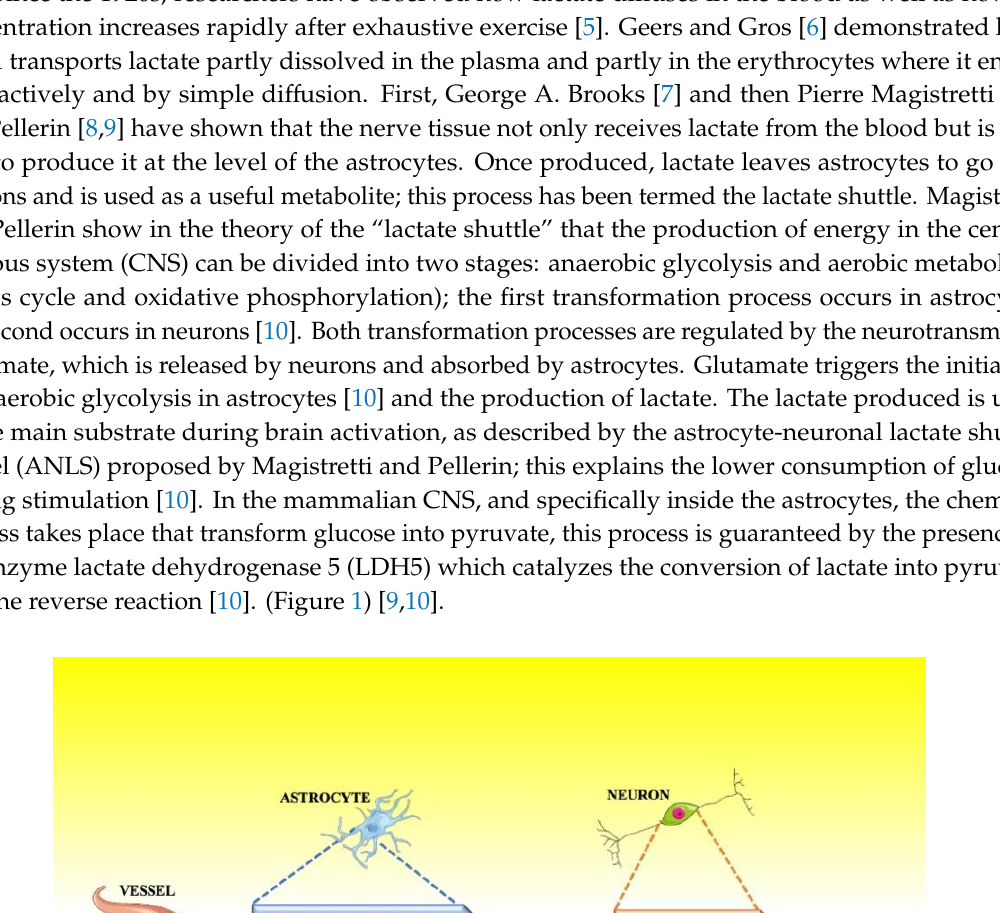
Figure 1. Shuttle model .